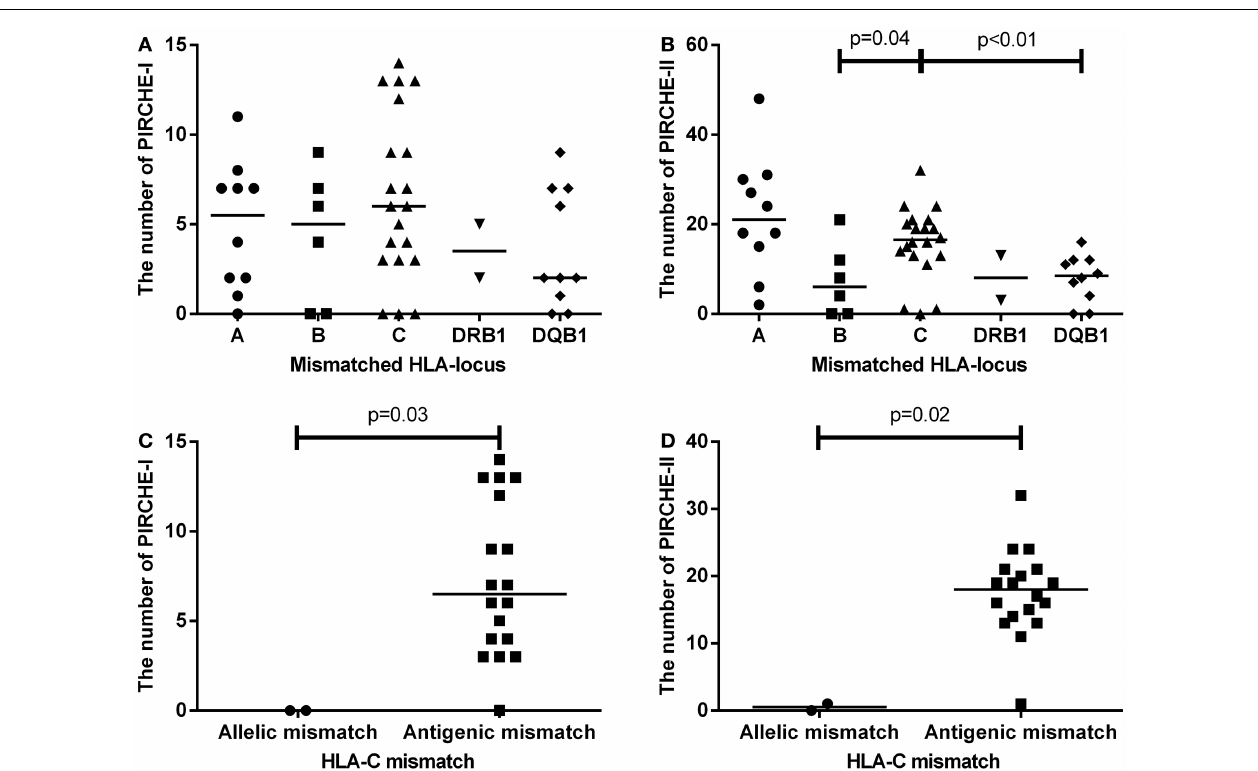
lines indicate the median value and the differences between groups were tested with Mann–Whitney U tests. Patients with an HLA-C mismatch had a significantly higher number of PIRCHE-II compared to patients with an HLA-B or -DQB1 mismatch. Patients with HLA-C antigenic mismatches, had higher number of PIRCHE-I and -II compared to allelic